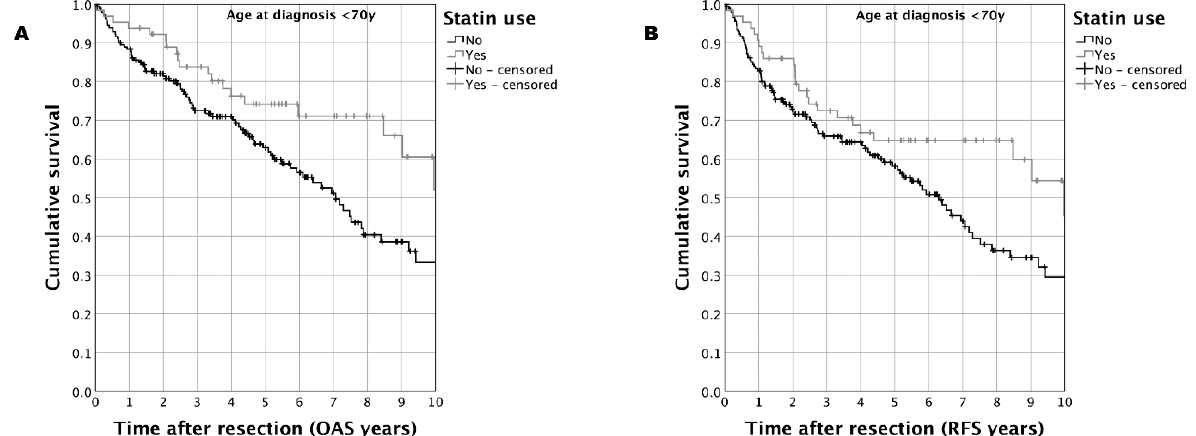
Figure 2. Survival in a matched-pair cohort of OSCC patients with age at diagnosis <70 years ( n = 246) comparing patients taking statins at the time of diagnosis compared to those patients without statin treatment: ( A ): Kaplan–Meier analysis for OAS ( p = 0.014); ( B ): Kaplan–Meier analysis for RFS ( p = 0.032).